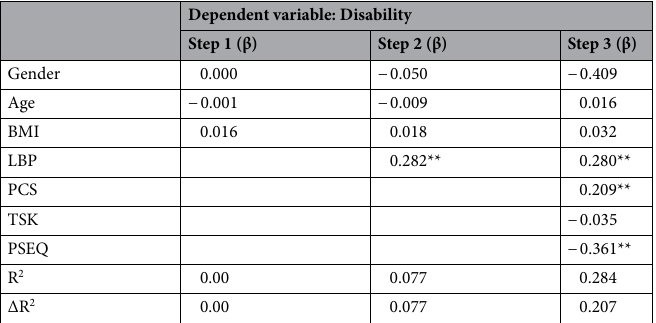
Table 4. Results of hierarchical linear regression analysis for acute NSLBP group. *p < 0.05, **p < 0.01. β Standardized coefficients, NSLBP non-specific low back pain, LBP low back pain, BMI Body Mass Index, PCS Pain Catastrophizing Scale, TSK Tampa Scale for Kinesiophobia, PESQ Pain Self Efficacy Questionnaire, RMDQ Roland Morris Disability Questionnaire, R 2 the proportion of explained variance in dependent variable by the model, ΔR 2 the change in R 2 values from one model to